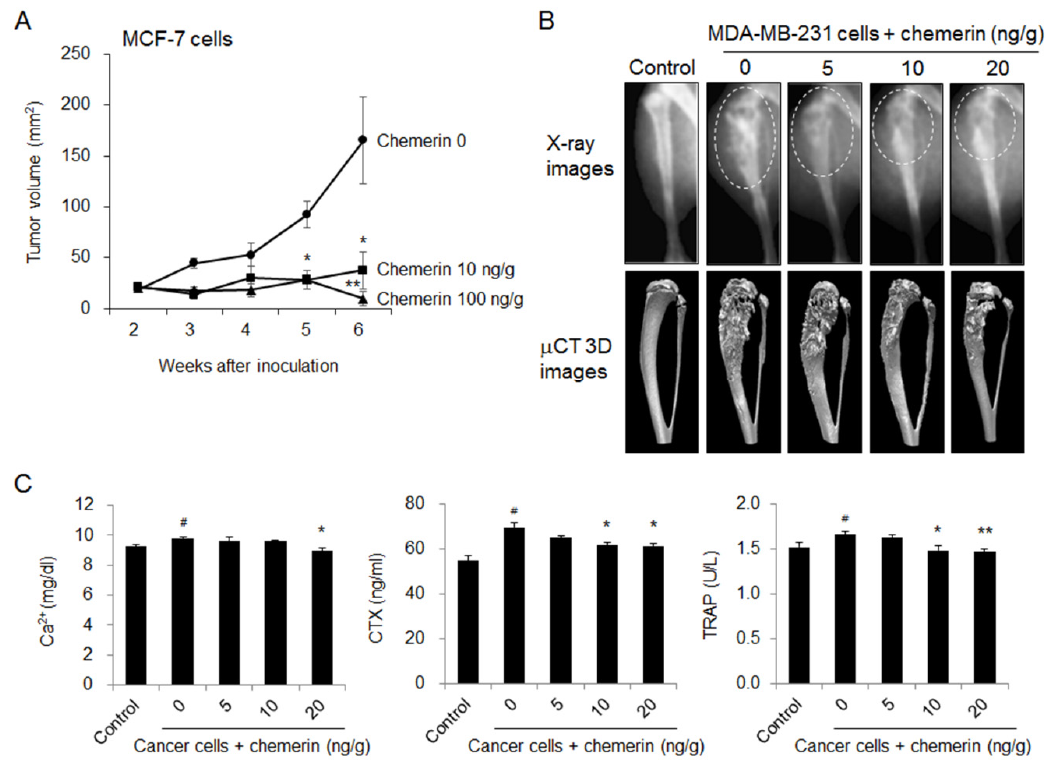
Figure 6. Chemerin suppressed tumor growth and breast cancer cell-associated bone loss in mice. ( A ) Tumor growth in mice inoculated with MCF-7 breast cancer cells in the presence of a β -estradiol pellet and then intraperitoneally administered with chemerin for 6 weeks. * p < 0.05, ** p < 0.01 versus MCF-7 cell-inoculated mice; ( B ) Representative radiophotographic and µ CT 3D images of osteolytic lesions (dotted circles) and ( C ) serum levels of bone turnover markers in mice with intratibial inoculation of MDA-MB-231 breast cancer cells followed by intraperitoneal administration of chemerin for 5 weeks. # p < 0.05 versus control mice, * p < 0.05, ** p < 0.01 versus MDA-MB-231 cell-inoculated mice.